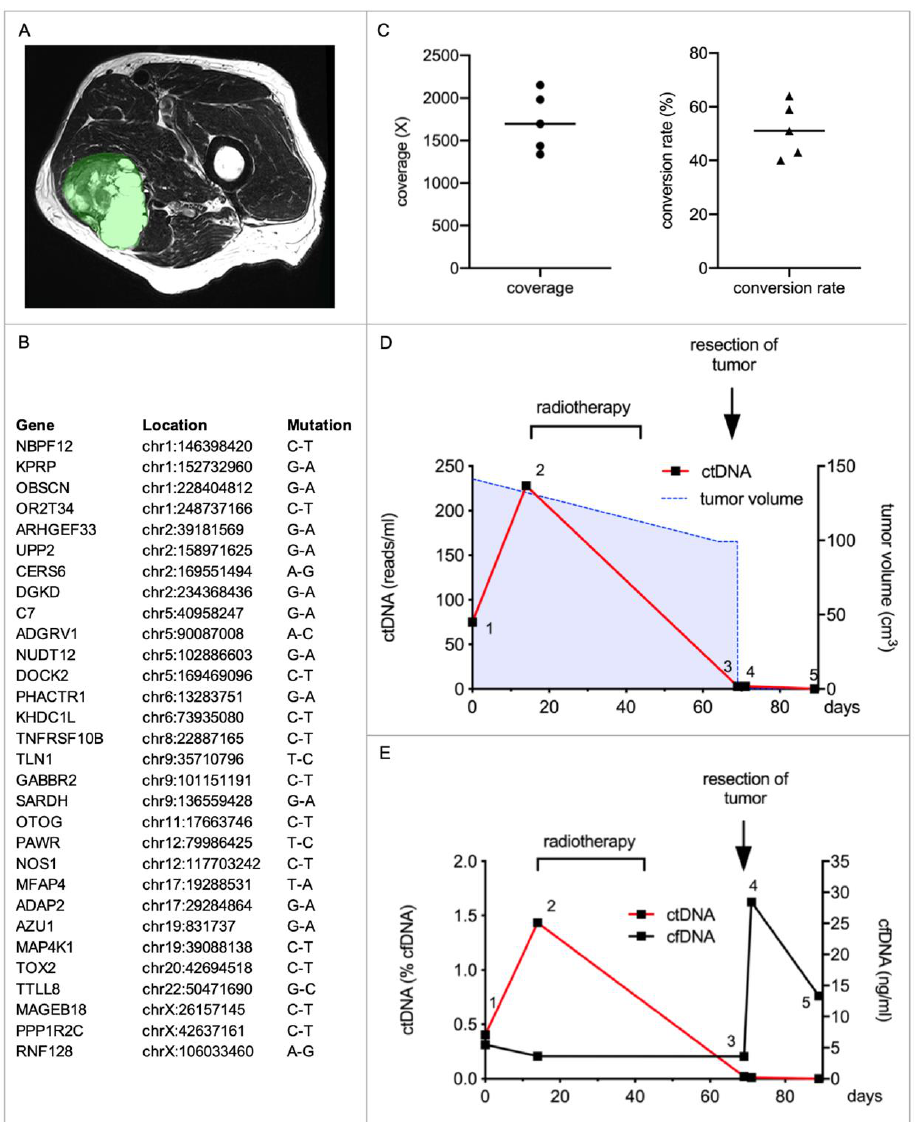
Figure 1. ctDNA enables monitoring of the treatment response of neoadjuvant radiotherapy and tumor resection in a patient with myxofibrosarcoma. ( A ) The patient presented with a primary tumor (tumor volume: 141.2 cm 3 ) of his left thigh. Shown is a representative section of the MRI imaging with the tumor highlighted in green. After interdisciplinary case discussion, neoadjuvant radiotherapy was initiated before the tumor was surgically removed. ( B ) An individual mini-panel covering 30 mutations identified by exome sequencing was established for targeted NGS. Genomic coordinates are based on GRCh37 (hg19). ( C ) Five plasma samples were collected during his treatment, cfDNA was isolated, and ctDNA was therein quantified. Depicted are the coverage (circles) and conversion rates (triangles) of each sample after building UMI consensus families. Means are illustrated by horizontal bars. ( D ) Absolute quantification of ctDNA during the course of his treatment. Sample 1 and 2 were obtained before initiation of radiotherapy, sample 3 before surgery, and sample 4 and 5 after tumor removal. Depicted are absolute amounts of ctDNA (red line). The tumor volume, as calculated from MRI imaging, is depicted by the blue dashed line. ( E ) Depicted are the cfDNA concentrations (black line) and relative amounts of ctDNA (red line) in the same five plasma samples.